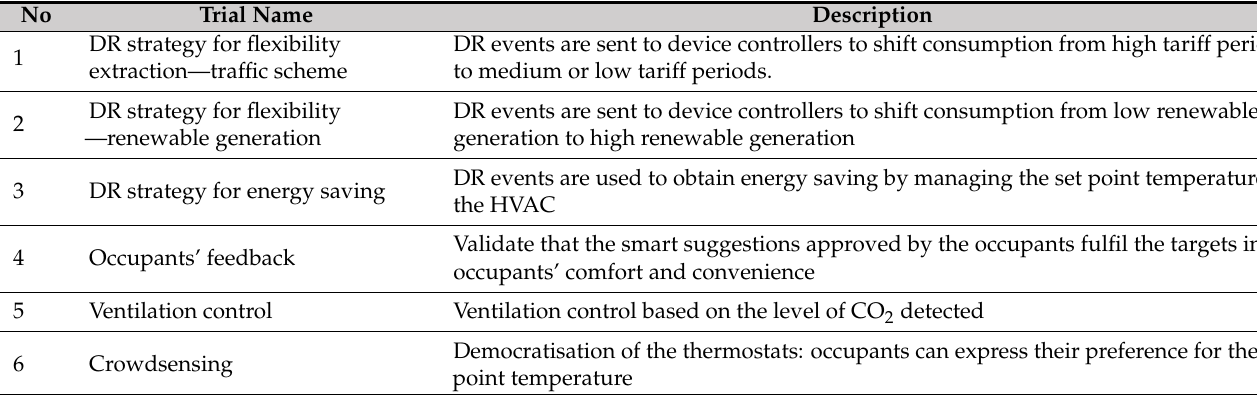
Table 3. PoC’s trial